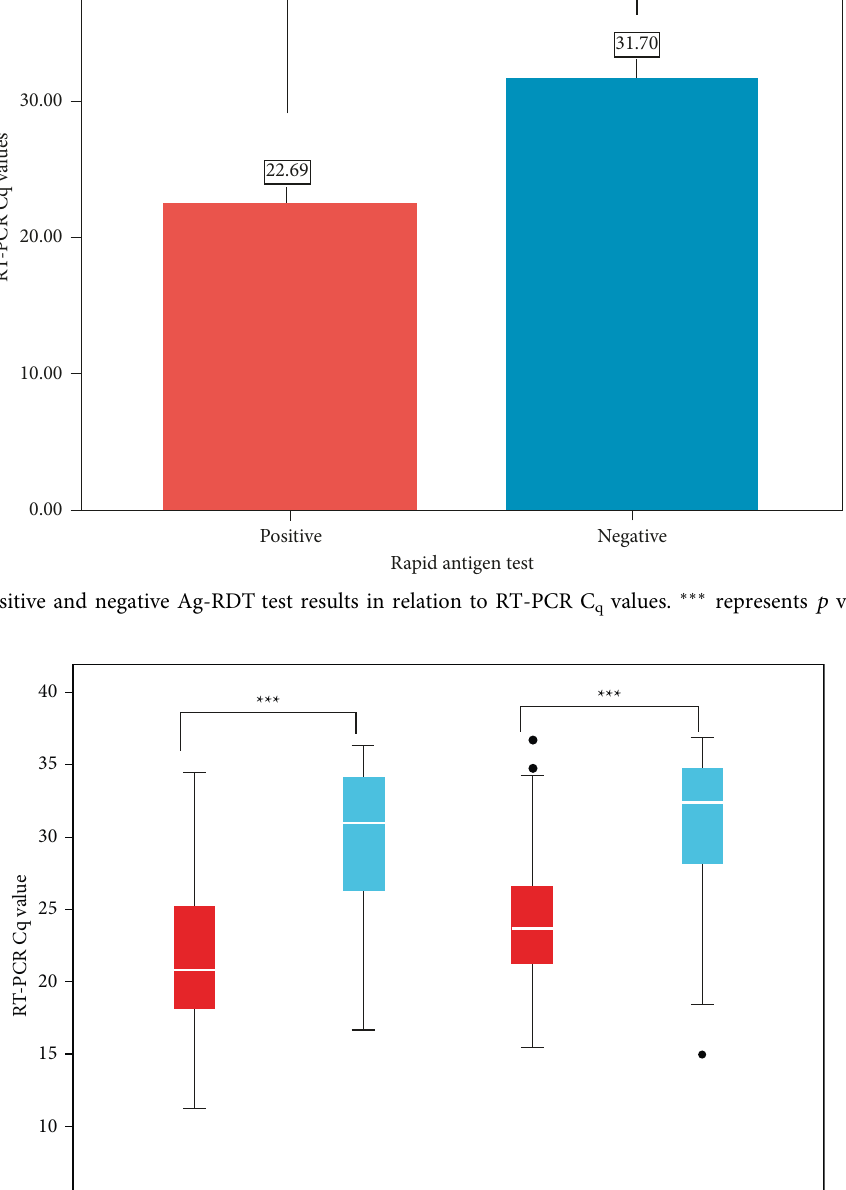
Figure 4: Distribution of ORF1ab gene and N gene C q value in positive and negative rapid antigen test results. Middle horizontal line inside the box denotes the median. The boxes represent interquartile range (lower, 1st quartile and upper, 3rd quartile). The lower and upper whiskers represent minimum and maximum C q value distribution, respectively. ∗∗∗ represents p value <